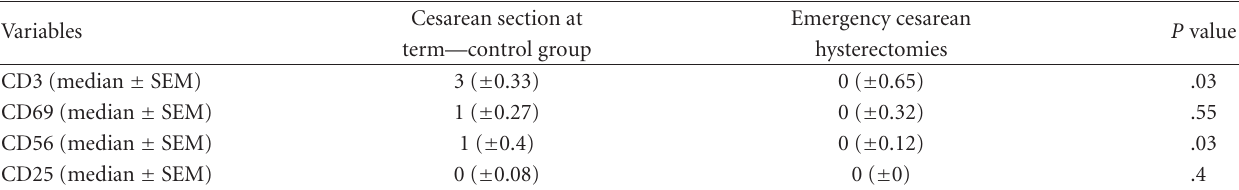
Table 4: Comparison between the number of CD3 positive and CD56 positive cells and the level of immunoreactivity of CD69, and CD25 antigens in case of emergency cesarean hysterectomies and cesarean section at term: control group.